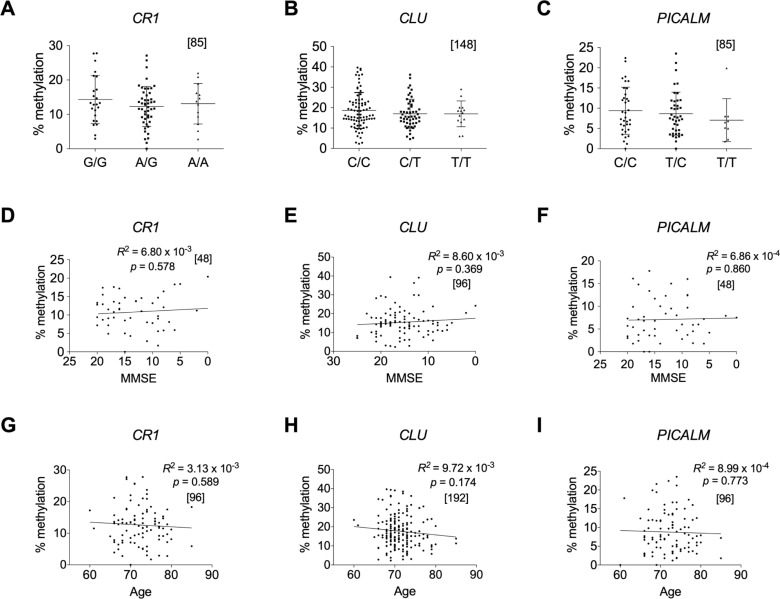
Methylation rates in AD-associated DMRs are independent of known AD-associated SNPs, MMSE, and age.Methylation rates in AD-associated DMR in CR1, CLU, and PICALM were plotted against the genotypes of AD-associated SNPs in CR1 (rs3818361) (A) and CLU (rs11136000), (B) and upstream of PICALM (rs3851179) (C). No significant differences were detected in any combinations of the genotypes in any regions by the Kruskal-Wallis test [non-parametric one-way ANOVA] with Dunn’s multiple comparison post-test. Methylation rates in DMR in CR1, CLU, and PICALM are also plotted against MMSE scores (D, E, F) and age (G, H, I), respectively. Relationships were analyzed based on Pearson’s correlation coefficient. The numbers of samples examined are shown in parentheses. Methylation rates were derived from AD and control subjects in the test group for (A), (C), (G), and (I), and from those in the test and replication groups for (B) and (H). Data from AD subjects in the test group or in the test and replication groups were used to plot methylation rates against MMSE for (D) and (F) or for €, respectively. All methylation rates were quantified at the same regions as in Fig 2 by Sanger sequencing. Relative positions of SNPs in the three genes and information on the SNPs genotyped in the test and replication groups are shown in S1–S3 Figs and S2 Table, respectively. Abbreviations: Ctrl subjects, control; AD, Alzheimer’s disease subjects; DMRs, differentially methylated regions; SNPs, single nucleotide polymorphisms; MMSE, Mini-Mental State Examination; ANOVA, analysis of variance.